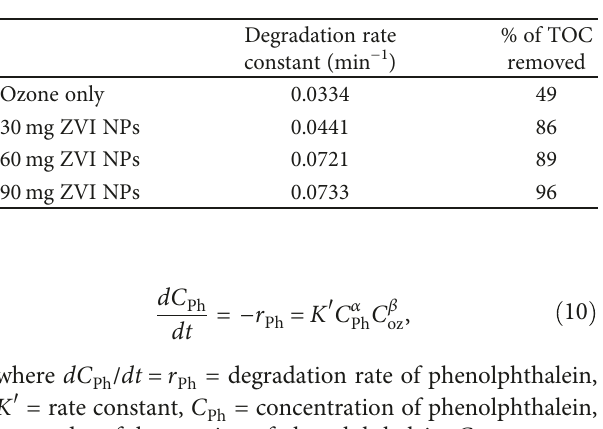
Table 1: Phenolphthalein degradation rate constants and TOC